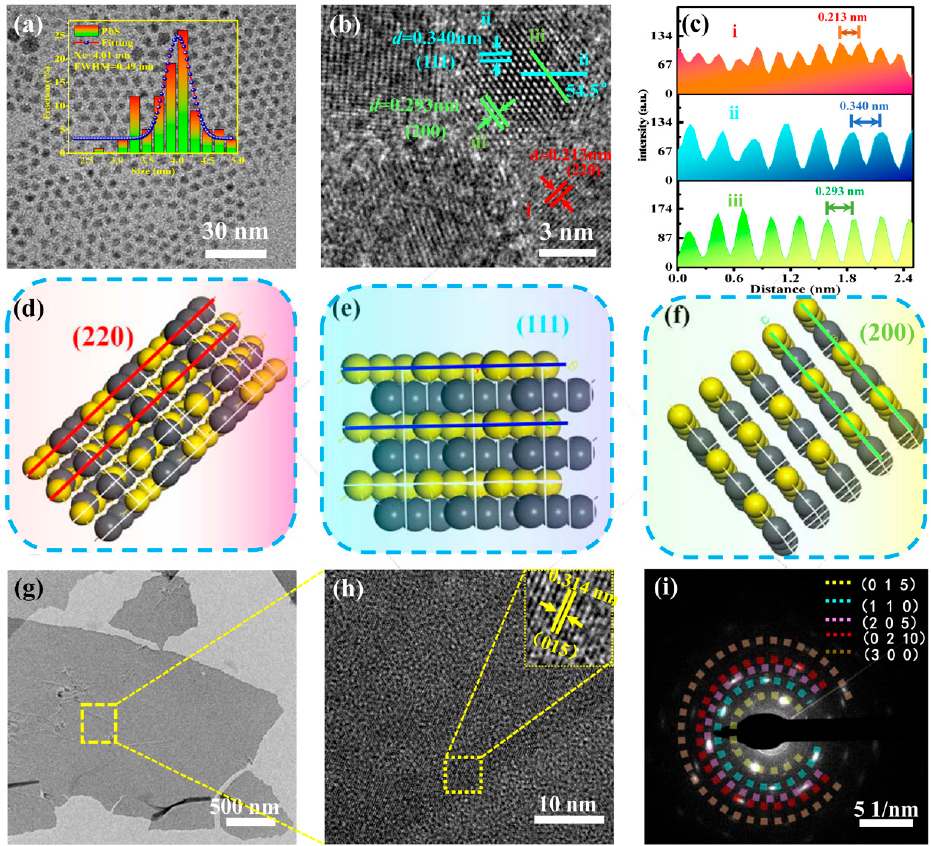
Figure 1. Structural characterization of PbS CQDs and Bi 2 Te 3 film. ( a ) Low-resolution TEM image of PbS CQDs. ( b ) HRTEM image of PbS CQDs. ( c ) Line profiles corresponding to the lines i–iii indicated in ( b ). ( d – f ) Schematic diagrams of PbS CQD crystal structures. ( g ) Low-resolution TEM image of Bi 2 Te 3 film. ( h ) HRTEM image showing lattice fringes of Bi 2 Te film. ( i ) Electron diffraction pattern of Bi 2 Te 3 film.